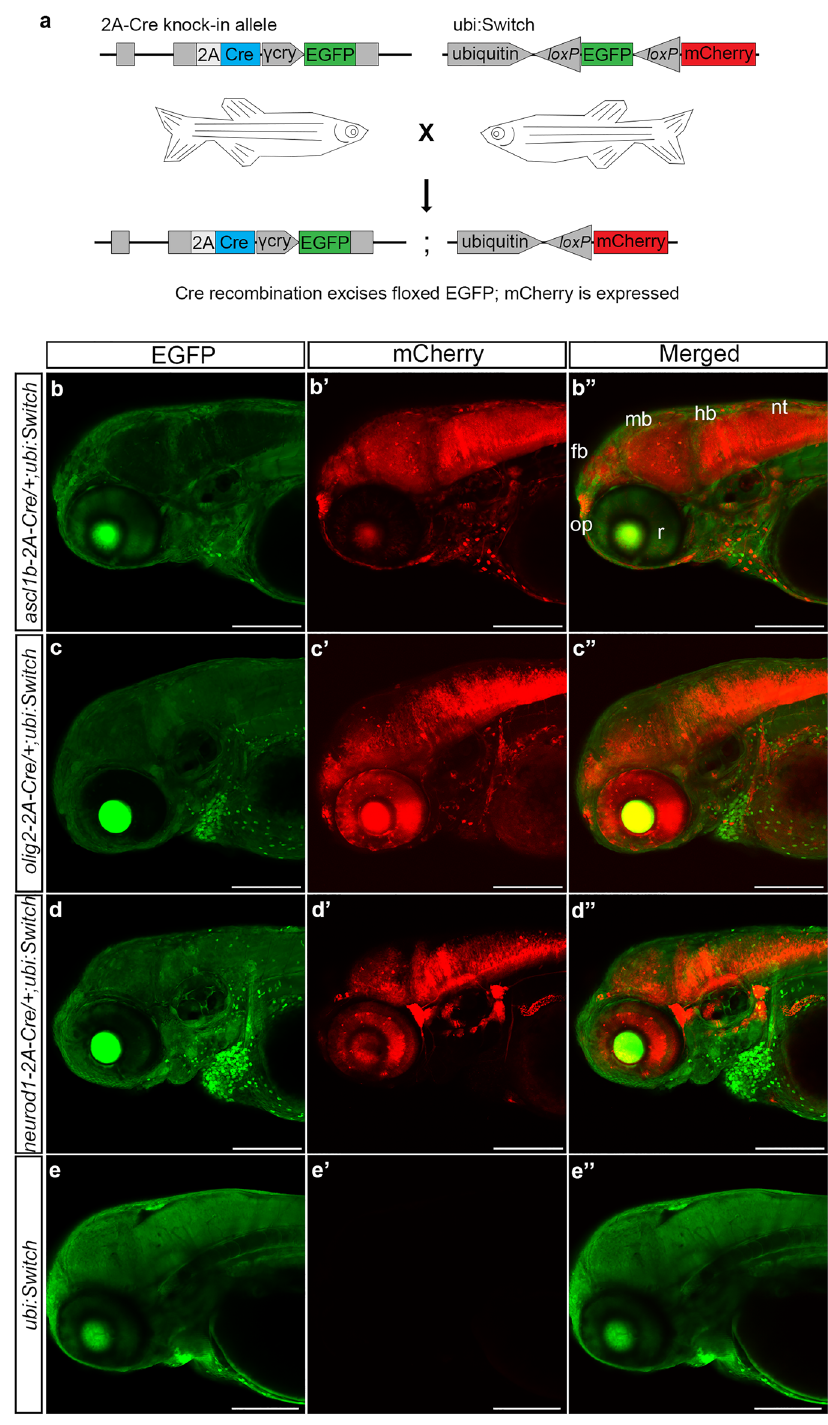
Figure 3. Transgenic ascl1b-2A-Cre , olig2-2A-Cre and neurod1-2A-Cre lines express functional Cre that promotes recombination at loxP sites in the expected neural progenitor populations. ( a ) F0 adults harboring precise integration alleles were mated to the recombination reporter line ubi:Switch to generate double transgenic 2A-Cre driver; ubi:Switch embryos. ( b – d ) Confocal imaging of 3 dpf double transgenic ascl1b-2A- Cre ; ubi:switch ( b ), olig2b-2A-Cre ; ubi:switch ( c ), and neurod1-2A-Cre ; ubi:switch ( d ) larvae shows a switch from GFP to mCherry expression in neural cells derived from ascl1b , olig2 , and neurod1 progenitors. ( e ) A switch from GFP to mCherry expression isn’t detected in single transgenic ubi:Switch larvae. fb forebrain, γ -cry gamma crystallin promoter, EGFP green fluorescent protein, hb hindbrain, mb midbrain, nt neural tube, op olfactory placode, r retina. Scale bar 200